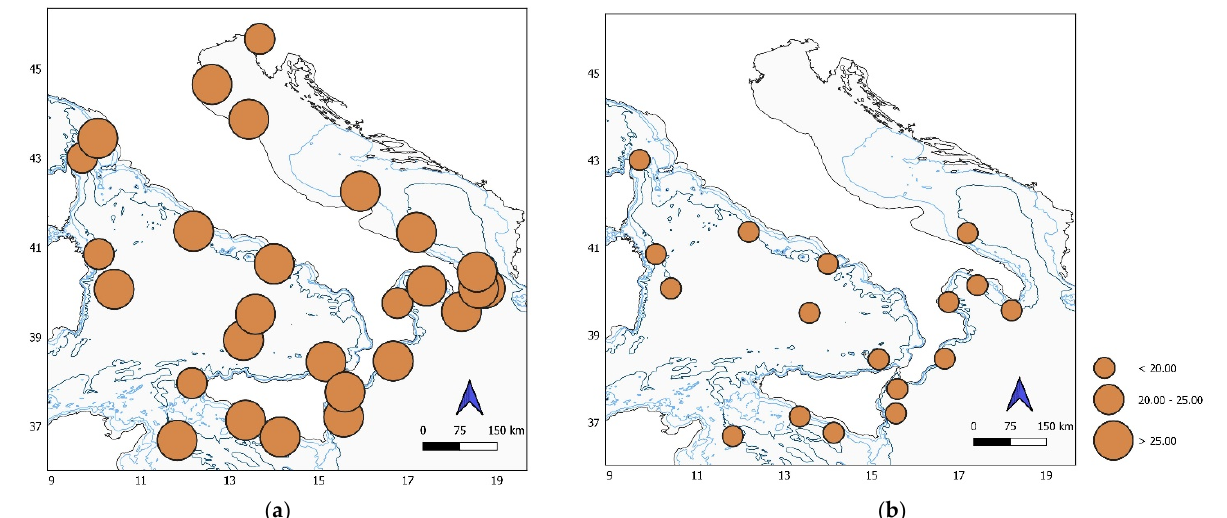
Figure 2 . Map of the study area showing differences in temperature (°C) of ( a ) epipelagic and ( b ) mesopelagic stations. Figure 2. Map of the study area showing differences in temperature ( ◦ C) of ( a ) epipelagic and ( b ) mesopelagic stations. The highest surface salinity (39.1) was recorded at station BA (Bari), notably higher